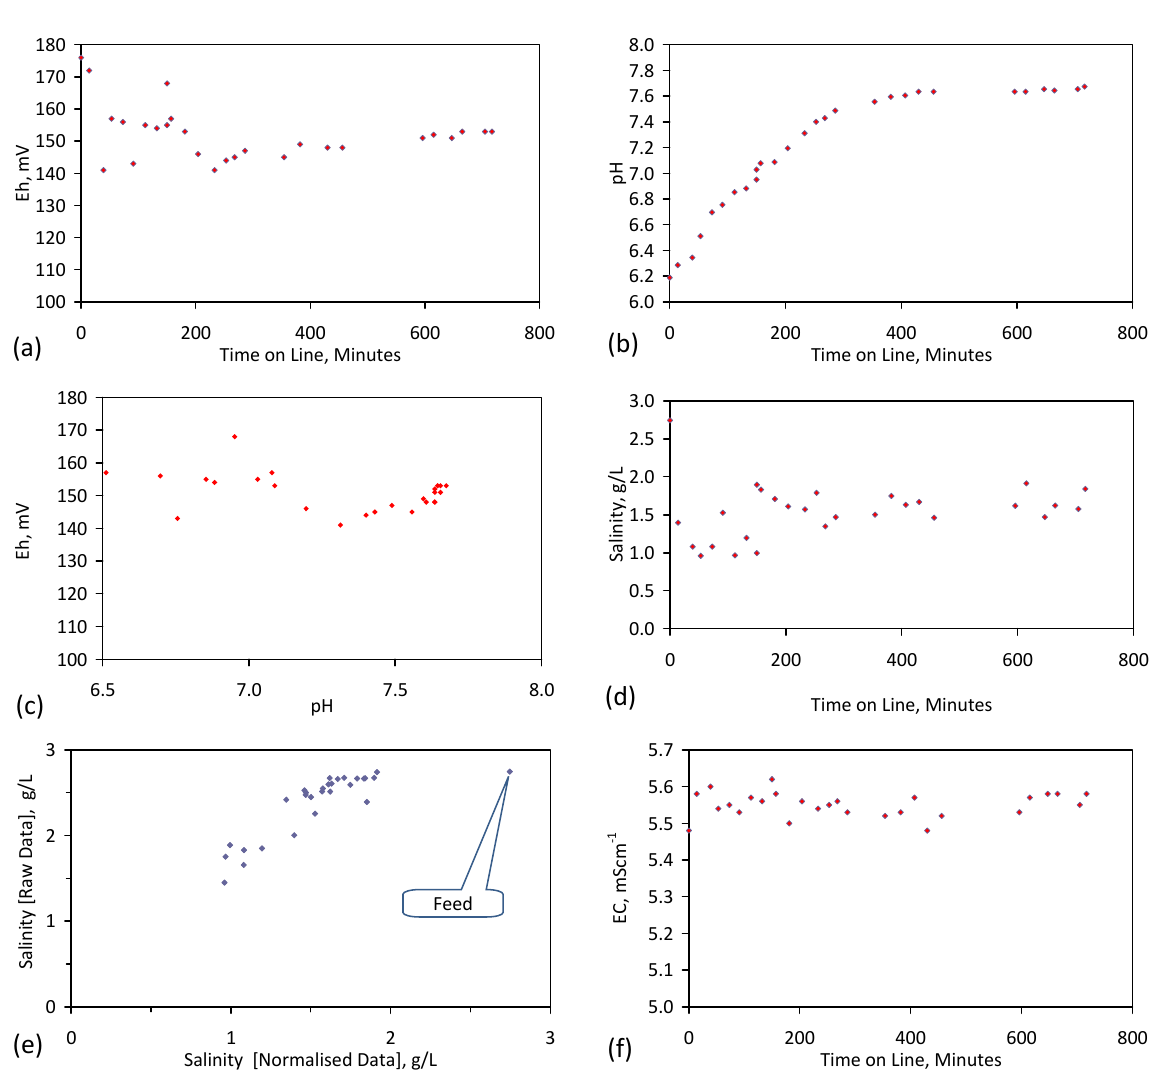
Figure C29. ZVM TPA example Trial E146. 9th Reuse; Operating Temperature: 16–20 °C; Oxidising Environment: Water volume in the reactor = 0.24 m 3 ; ZVM TPA from Trial E145 in a cartridge = 0.4 kg; Air flow = 120 L·h − 1 . ( a ) Eh vs. time; ( b ) pH vs. time; ( c ) pH vs. Eh; ( d ) Salinity vs. time; ( e ) Salinity calculated from normalised data vs. salinity calculated from raw data; ( f ) EC vs.